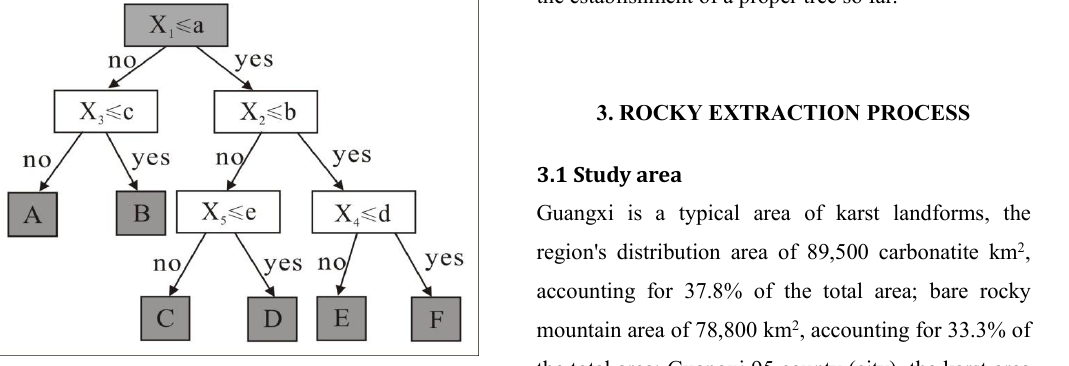
Figure 1. The tree structure of decision tree